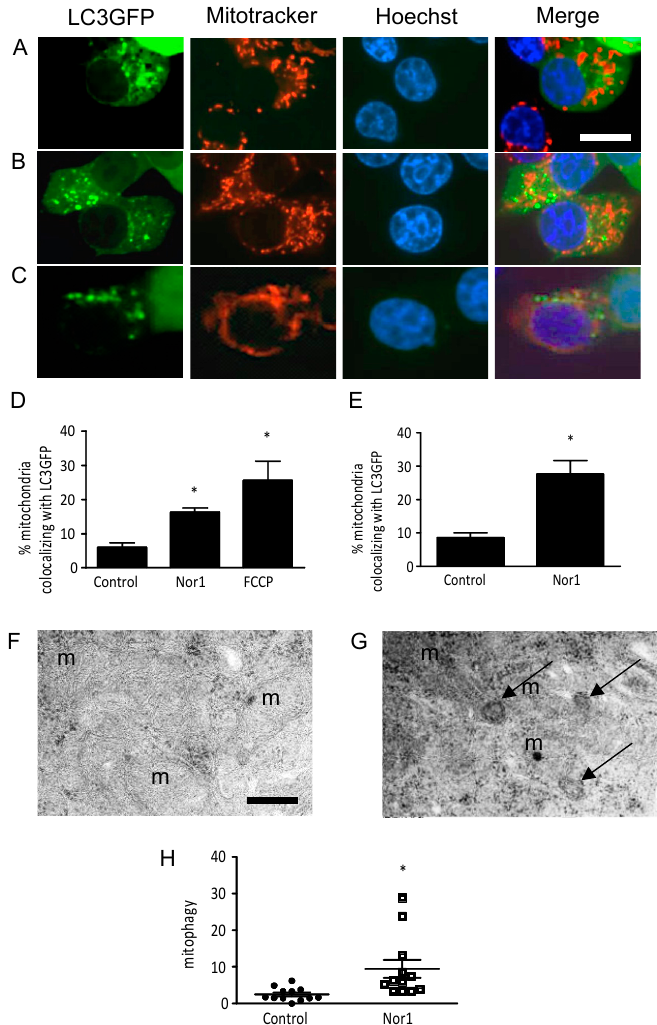
Figure 6. Nor1 increases mitophagy in beta cells. ( A – C ) Immunofluorescence images of INS832 / 13 cells transfected with LC3-GFP along with Nor1 ( B ) or a control vector ( A , C ). FCCP (20 µ M, 15 min) was used as a positive control in ( C ). Scale bar = 10 µ m. ( D ) Quantification of the colocalization between LC3-GFP and mitochondria in INS832 / 13 cells ( n = 3). Results are expressed as the percentage of mitochondria (red signal) colocalizing with LC3-GFP in each group. ( E ) Quantification of the colocalization between LC3-GFP and mitochondria in dispersed human islets cells ( n = 4). Results are expressed as fold change over untreated control cells. ( F , G ) TEM images of mitochondria in control INS832 / 13 cells ( F ) and cells transfected with Nor1 ( G ). Arrows indicate autophagosomes. Scale bar = 250 nm. ( H ) Quantification of the number of autophagosomes targeting mitochondria per cell area in TEM images. All results are represented as mean ± SEM; *, p < 0.05 versus